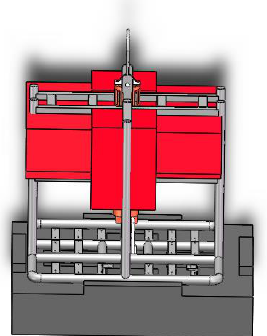
Figure 5. Three-dimensional physical model.